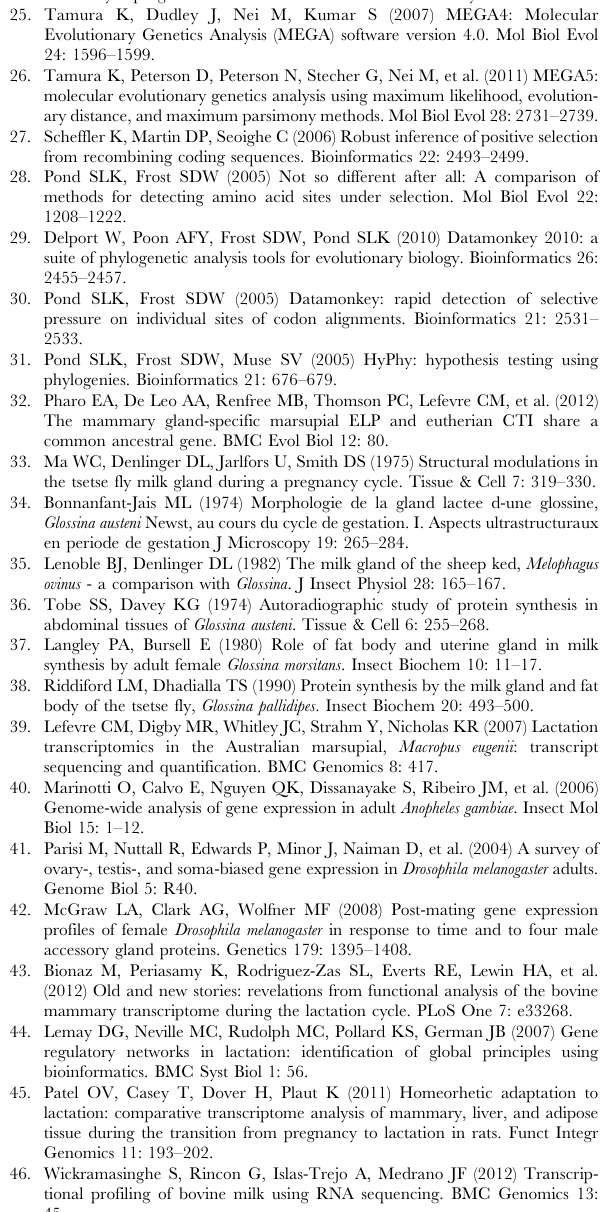
Table S7 Complete results for proteomic analysis of tsetse milk secretion. (XLSX) Table S8 Amino acid composition of milk gland proteins 2–10 as percent amino acids per protein. Total represents the average percent across MGP2–10. Highlighted are the essential amino acids. (XLSX) Text S1 Validation of RNA-seq data with qPCR. Correlation of log 2 ratios from RNA-seq and qPCR values for seventeen genes. The Pearson’s correlation coefficient (0.934) and goodness of fit (R 2 = 0.872) were high, indicating a high degree of correlation